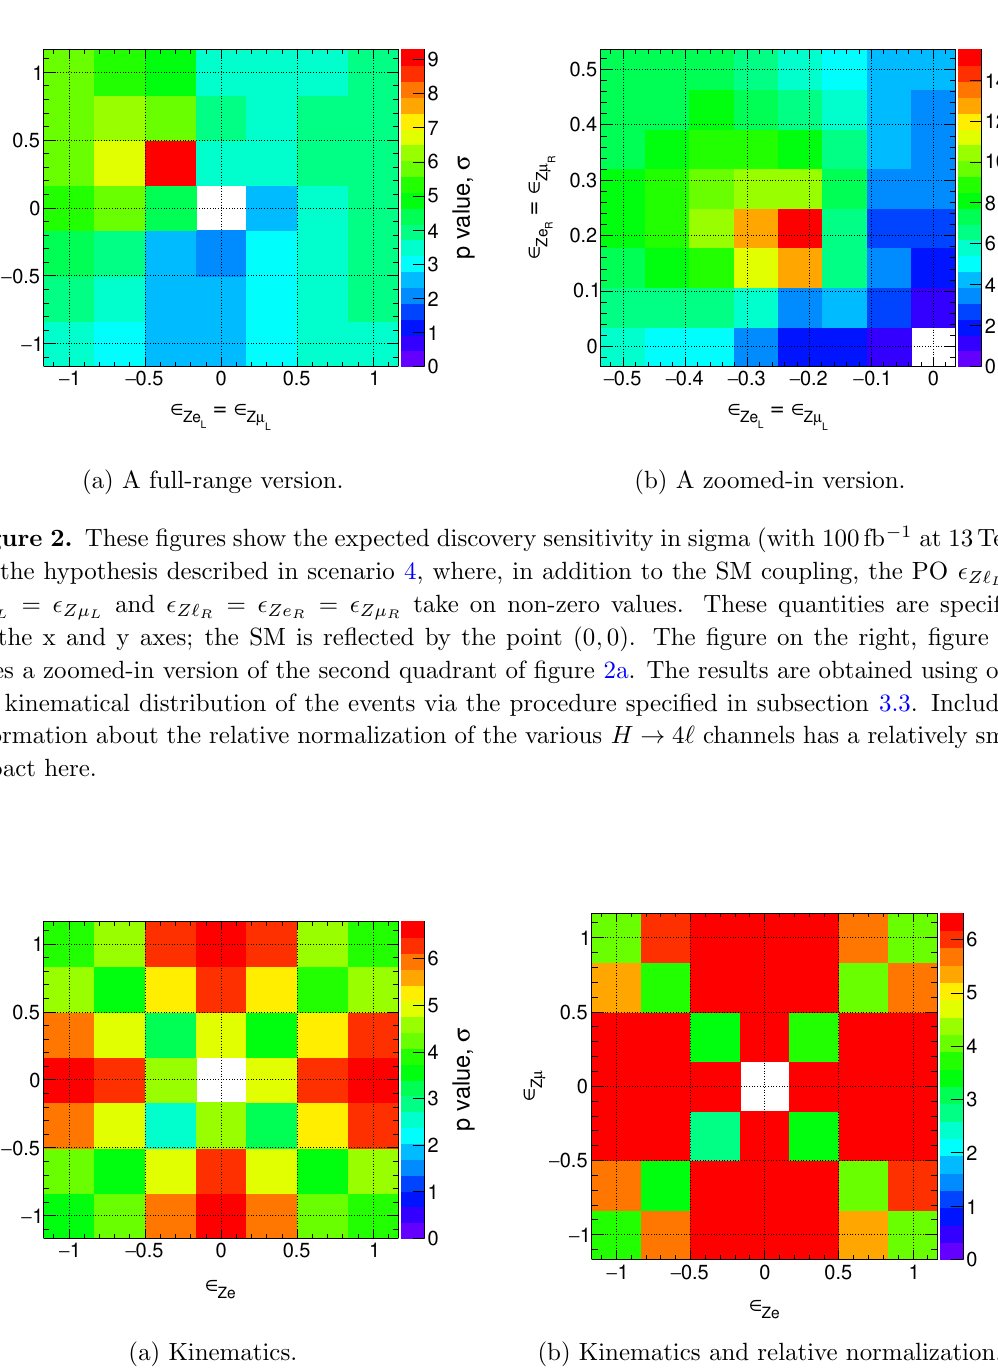
= (cid:15) Ze and (cid:15) Z(cid:22) = (cid:15) Z(cid:22) = (cid:15) Z(cid:22) . L R L R